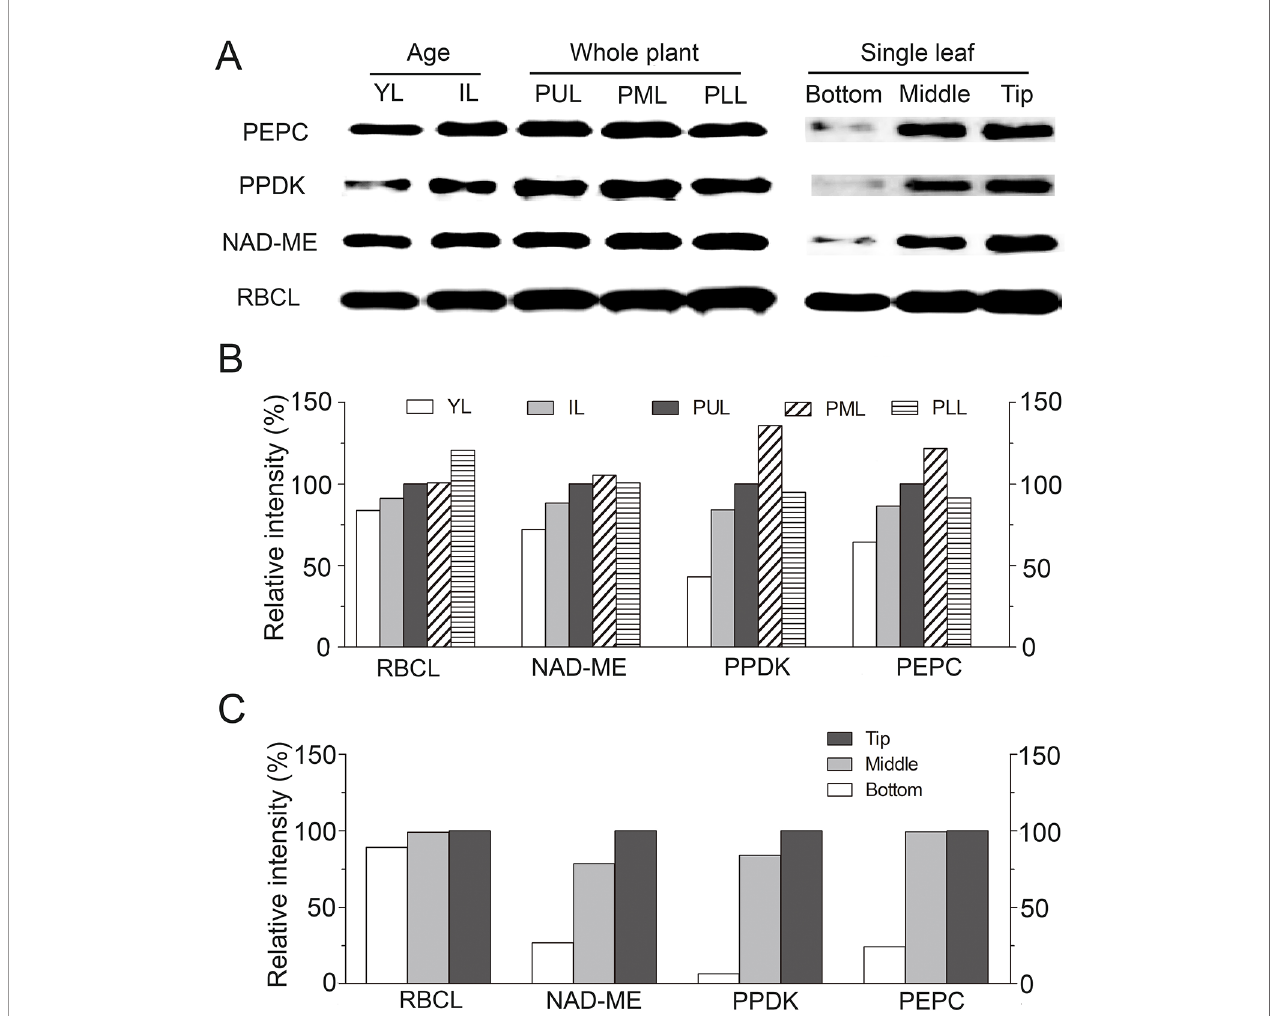
FIGURE 11 | Translational expression patterns of key photosynthetic enzymes in leaf of different positions of plant or along longitudinal direction in S. ferganica . (A) Western blotting showing the detection of four proteins; (B, C) Quantitative expression of western blotting data by ImageJ. YL, young leaf (0.2 – 0.3 cm); IL, intermediate leaf (0.5 – 0.6 cm); PUL, PML, PLL: the upper, middle, lower layer of the plant; Bottom, Middle, Tip: Different segments, along longitudinal leaf gradient. Relative intensity (RI) is represented as the sample intensity divides the reference intensity. For RI of each enzyme in YL, IL, PUL, PML, and PLL, the ‘ PUL ’ was used while for bottom, middle, and tip of leaf, the 'Tip' was used as reference in calculation. All samples were collected from indoor plants. Total soluble proteins were extracted from different ages of leaves or different parts of single leaf. Protein loading amount in each lane was 10 m g. Preparation and dilution of fi rst and secondary antibodies were described in Materials and